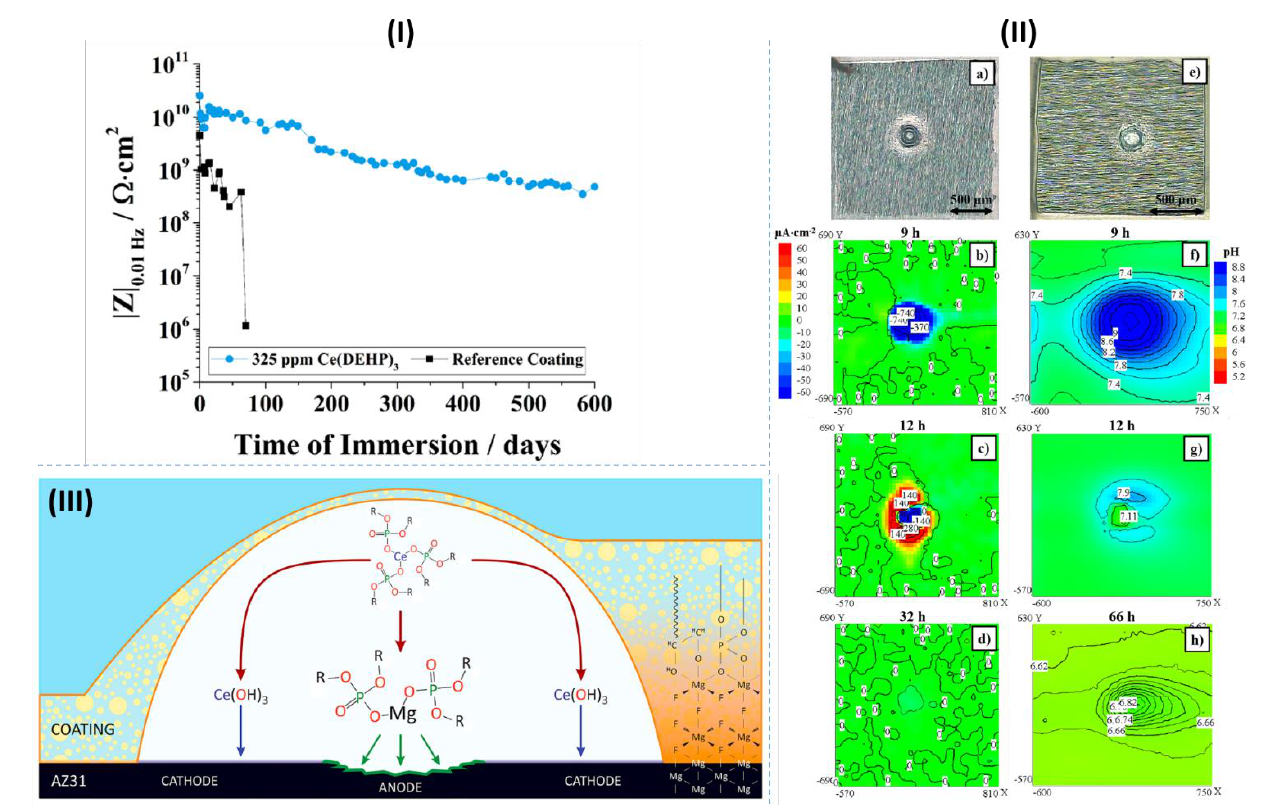
Figure 17. ( I ) Evolution of low-frequency impedance modulus (0.01 Hz, obtained through EIS) for reference and Ce(DEHP) 3 -modified coatings during immersion in 0.05M NaCl. ( II ) Optical micrographs, and SVET ( b – d ) and SIET ( f – h ) maps obtained for different immersion times of the Ce(DEHP) 3 -modified coating in 0.05M NaCl. Optical micrographs correspond to the beginning of immersion for SVET ( a ) and SIET ( e ) measurements. ( III ) Schematic mechanism of action of Ce(DEHP) 3 corrosion inhibitor added to the hybrid epoxy-silane coating for protection of magnesium alloy substrate. R represents the hydrocarbon chain. Adapted from [200] with permission from